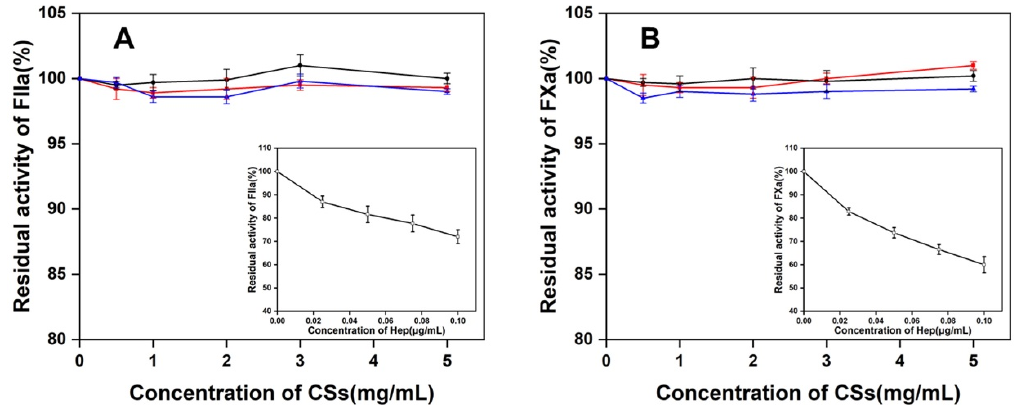
Figure 9. The effect of CSs from sturgeon cartilage to the effect of residual FIIa ( A ) or FXa ( B ) activity in the presence of ATIII. The standard Hep (□) was set as a reference (Insert). (●) SHCS; ( ■ ), SBCS; ( ▲ ) SFCS.